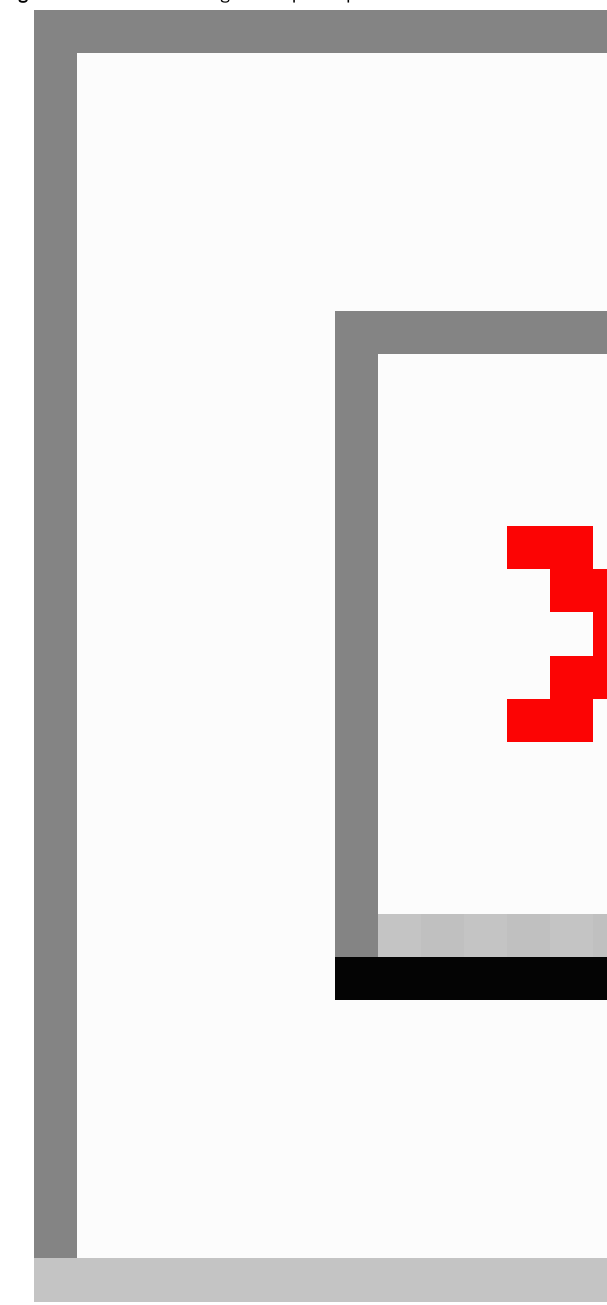
Figure 2. CONSORT diagram of